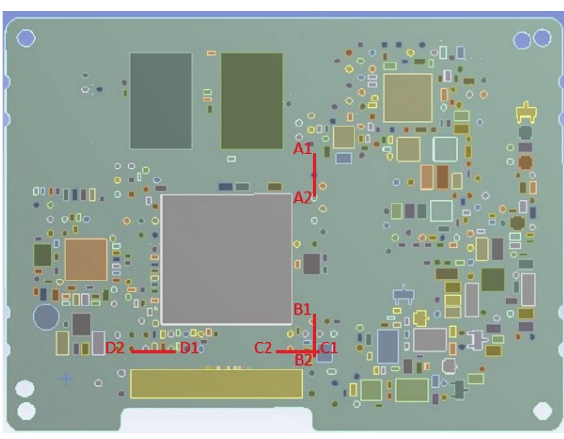
Figure 7: Definition of paths to interrogate the maximum principal strains results